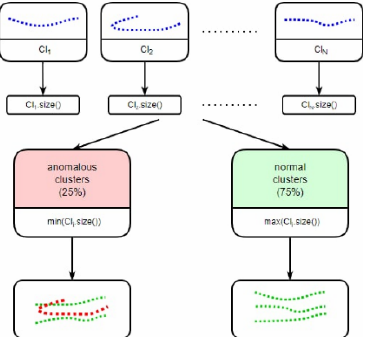
Figure 7. Normal and abnormal cluster construction.